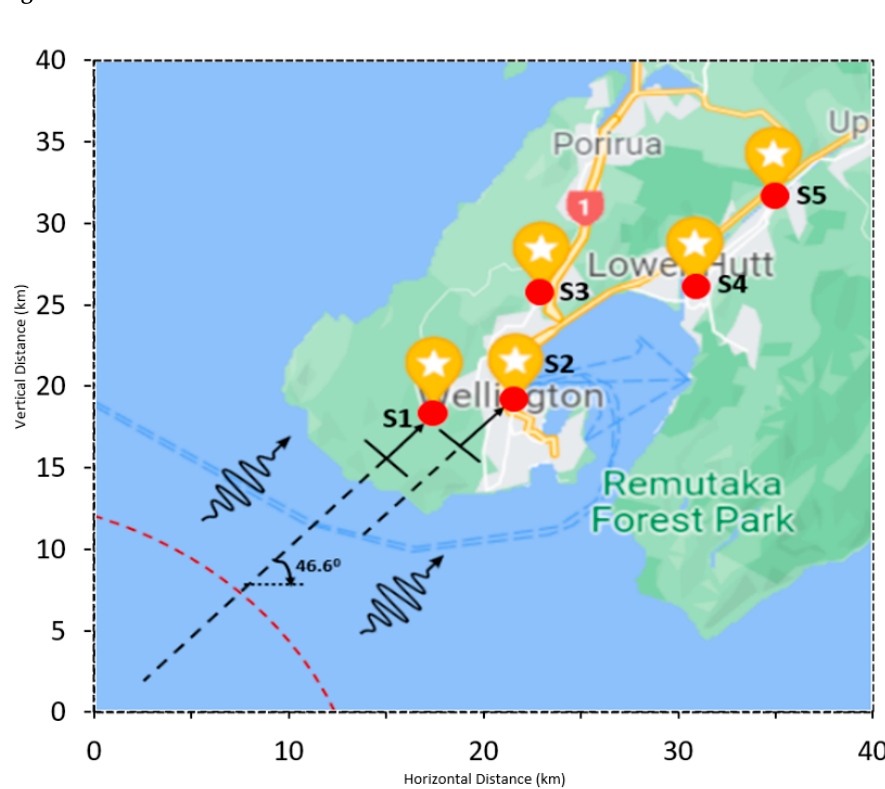
Figure A4. Scenario 4. Figure A4. Scenario